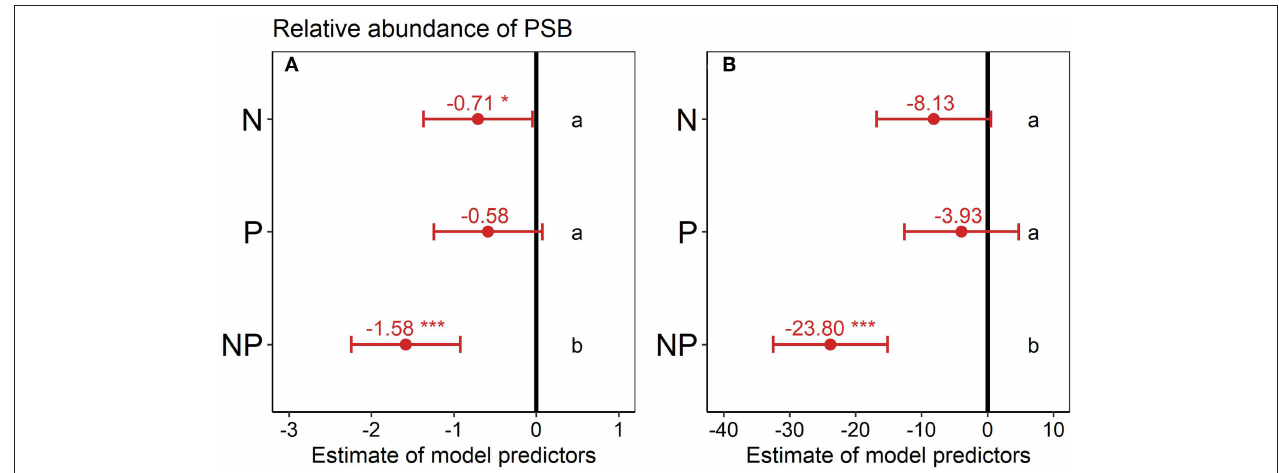
FIGURE 1 | Effect of nutrient addition (N, P, NP) on the relative abundance of phosphorus-solubilizing bacteria (PSB) across all six sites in (A) 0–15cm depth and (B) 15–30cm depth. A linear mixed-effects model was calculated with treatment as fixed factor and random intercepts for sites. Points represent the mean value of the model predictor while error bars represent the range of 95% confidence intervals. Predictors are considered significant, if error bars do not overlap with zero, indicated with asterisks. The vertical intercept (position zero) corresponds to the control. Significant differences between treatments are indicated by lower-case letters at the right side of the subplot.